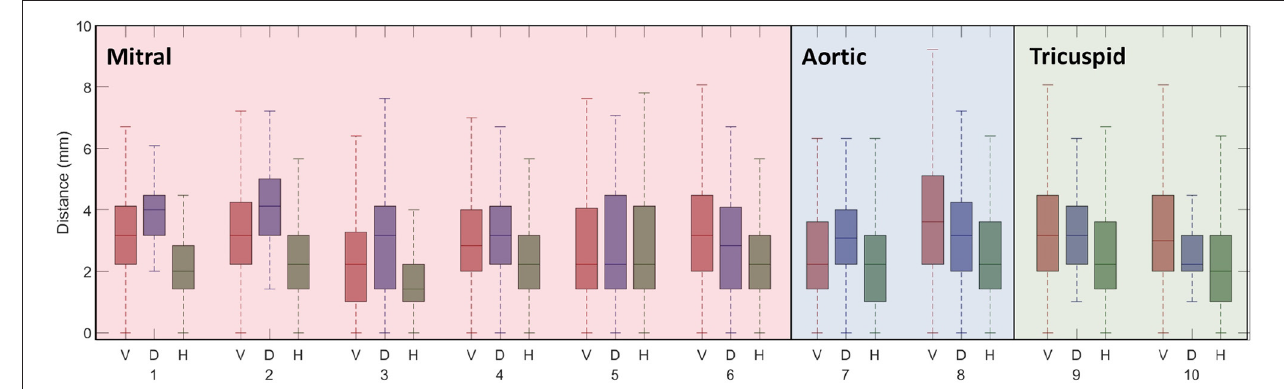
FIGURE 5 | Boxplots of valve annotation errors for all 10 valve landmarks are shown for selected healthy volunteers (V), DCM patients (D), and HCM patients (H) in which valve landmarks were manually identified over the entire cardiac cycle. Each boxplot represents errors throughout the cardiac cycle. The centre line of each boxplot represents the median and the whiskers denote the 25th and 75th percentiles. The 10 valve landmarks correspond to those shown in Figure 3 , Valve Landmark Identification .